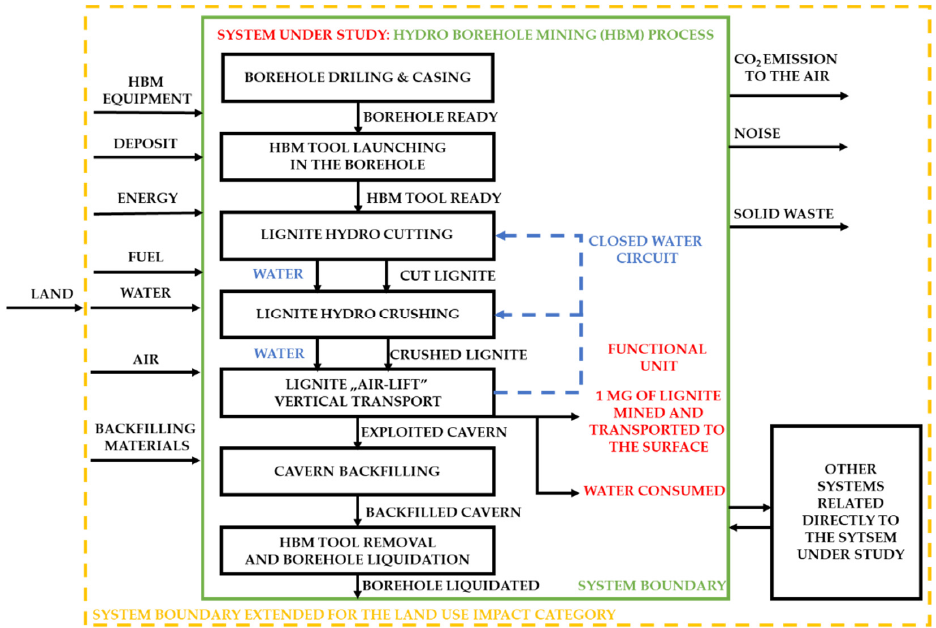
Figure 2. The system under an LCA study with its inputs, outputs, functional unit, and system boundaries included.